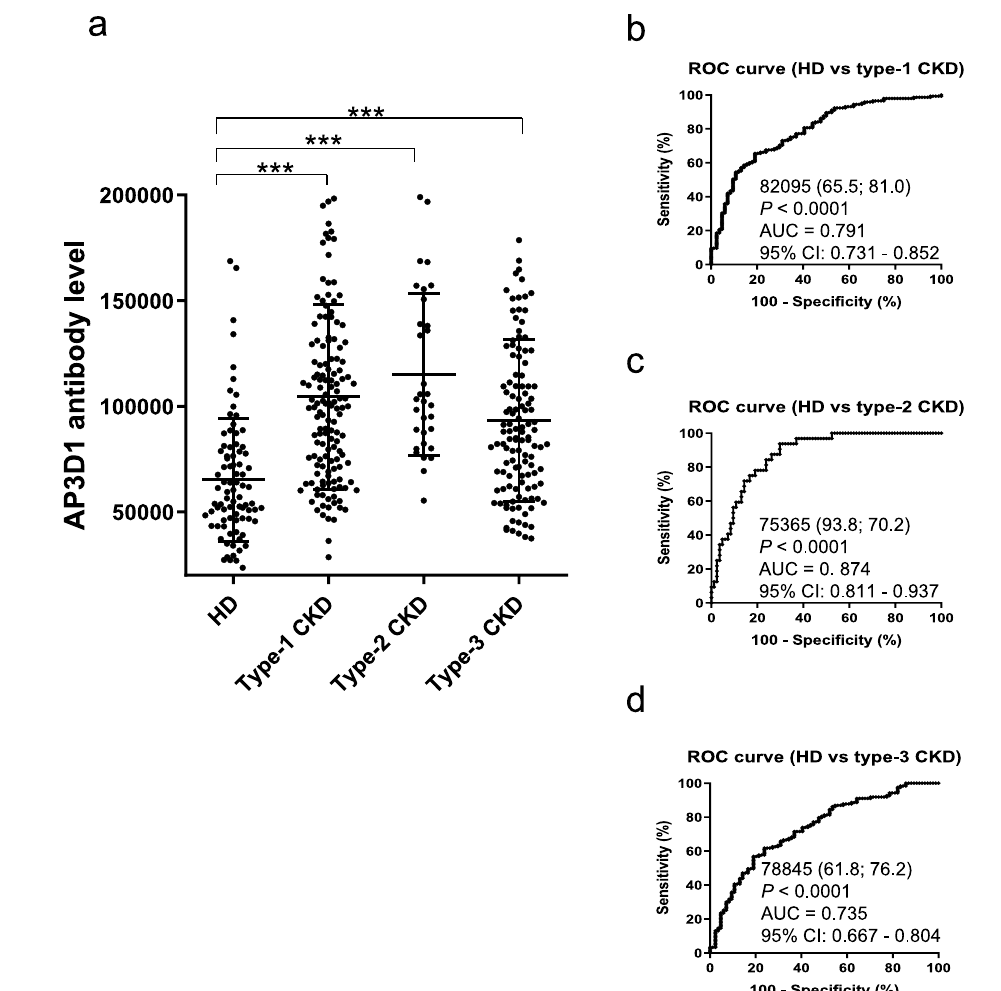
Figure 4. Comparing the serum AP3D1-antibody levels between HDs and patients with chronic kidney disease (CKD). ( a ) The s-AP3D1-Ab levels were compared between HDs and patients with diabetic CKD (type 1 CKD), nephrosclerosis (type 2 CKD), and glomerulonephritis (type 3 CKD). Results are presented as described in the legend of Fig. 1. P -values vs. HD controls were calculated using the Kruskal–Wallis test. *** P < 0.001. The